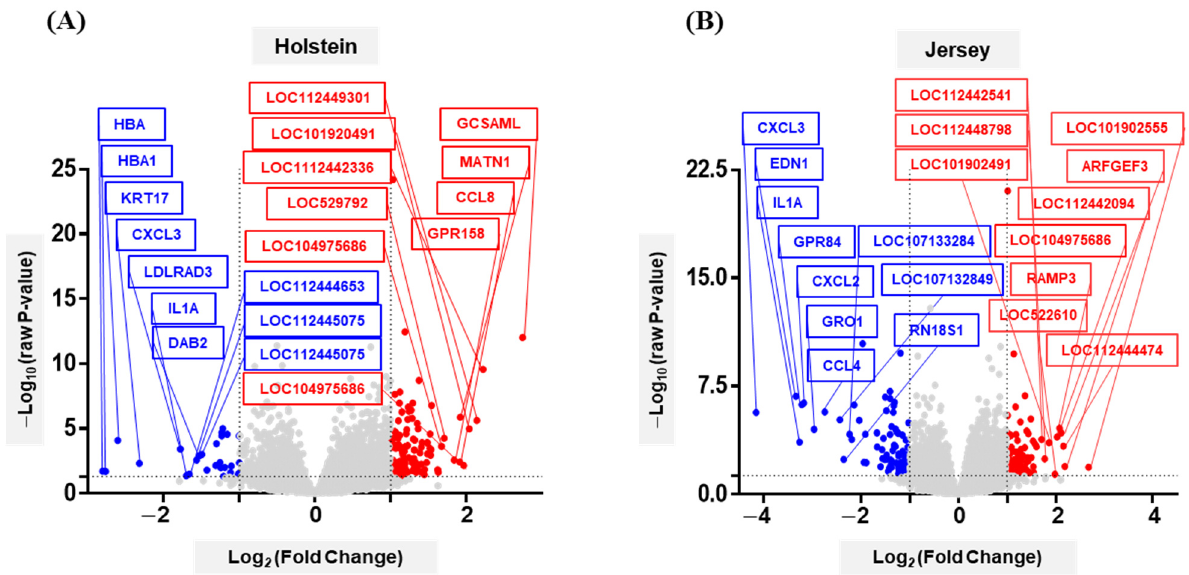
Figure 3. Volcano plots showing heat-stress-responding differentially expressed genes in Holstein and Jersey PBMCs. The DEGs in Holstein ( A ) and Jersey ( B ) PBMCs are presented in volcano plots ( p < 0.05, fold-change < − 2 or > 2). The top ten down-regulated (blue) or up-regulated (red) genes are highlighted.